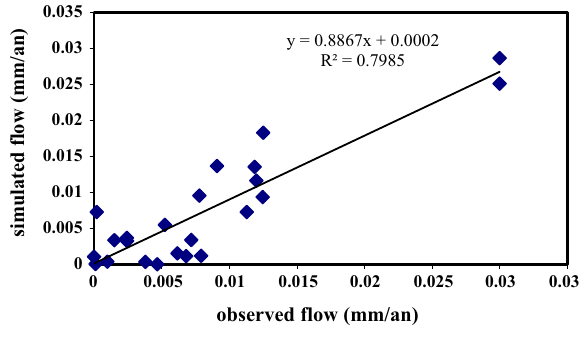
Fig. 4 Correlation between the observed flows and the simulated